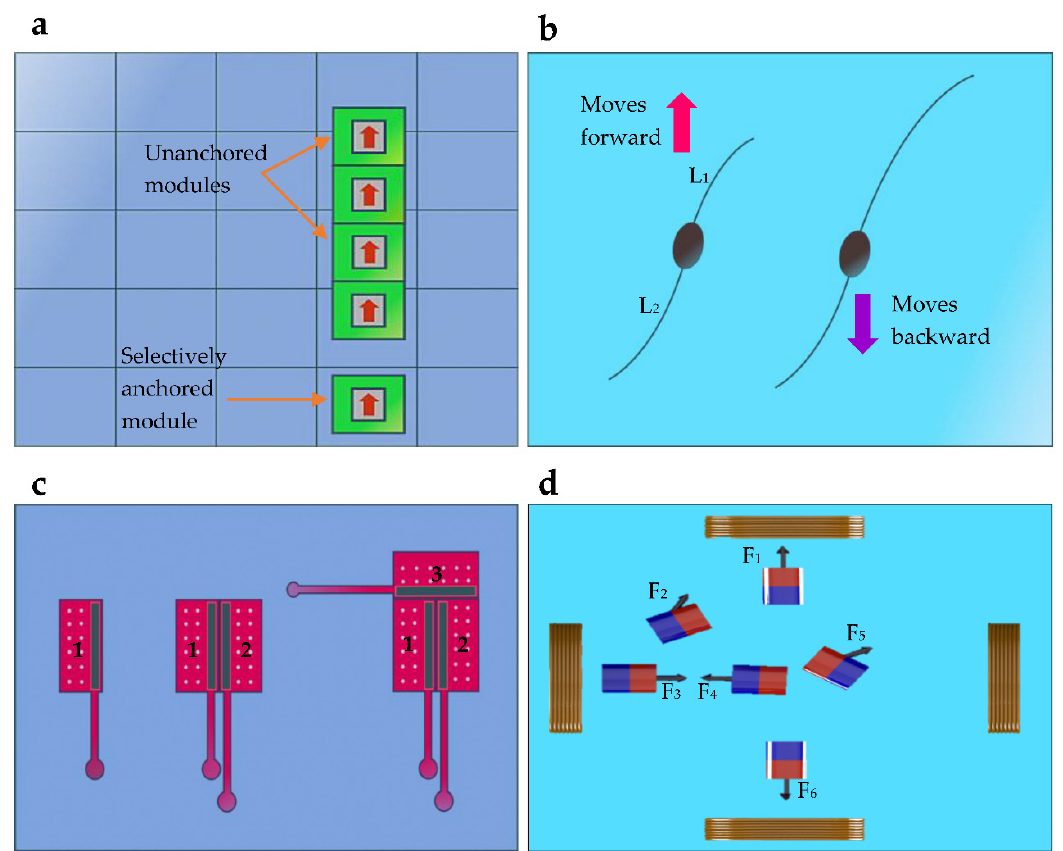
Figure 6. Shape formation techniques using selective control methods: ( a ) In the surface anchoring method, some modules are fixed to the surface selectively, whereas other modules navigate under external actuation [55]. ( b ) A two-tailed swimming microrobot design, where, depending on the tail length ratio ( 𝑙 (cid:2869) 𝑙 (cid:3415) ), the modules behave differently [59]. ( c ) Modules with differently sized arm-type structures exhibit different motions under the same actuation signals. These modules are navigated to form different shapes [88]. ( d ) Due to the spatial variation of the magnetic field, different microrobots experience different resultant forces [89].